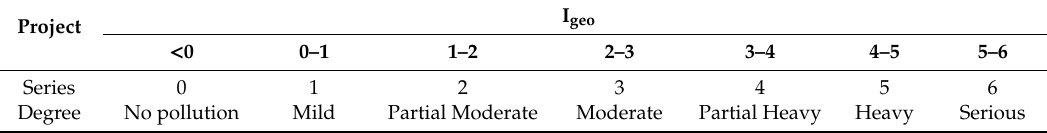
Table 1. The classification of I geo and the heavy metal pollution degree.